Question: In one sentence, what is this figure communicating?
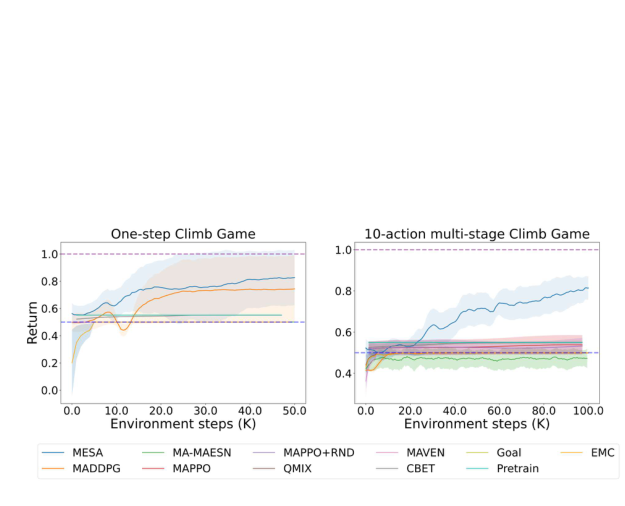
Answer: Learning curve of the two climb game variants w.r.t number of environment steps. The return is averaged over timesteps for the multi-stage games. The dotted lines indi- cate the suboptimal return of 0.5 (purple) and the optimal return 1 (blue) for each agent.